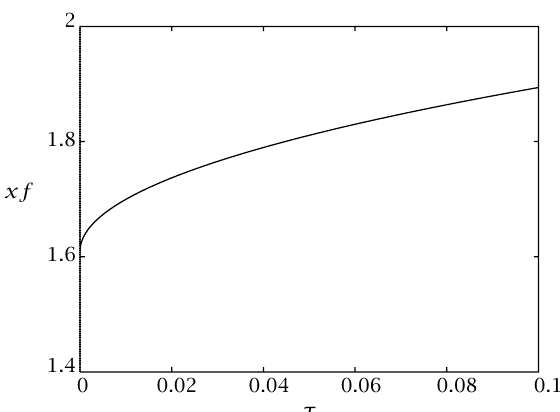
Figure 2.1 . Location of the free boundary for r = 0 . 1, D 0 = 0 . 02.